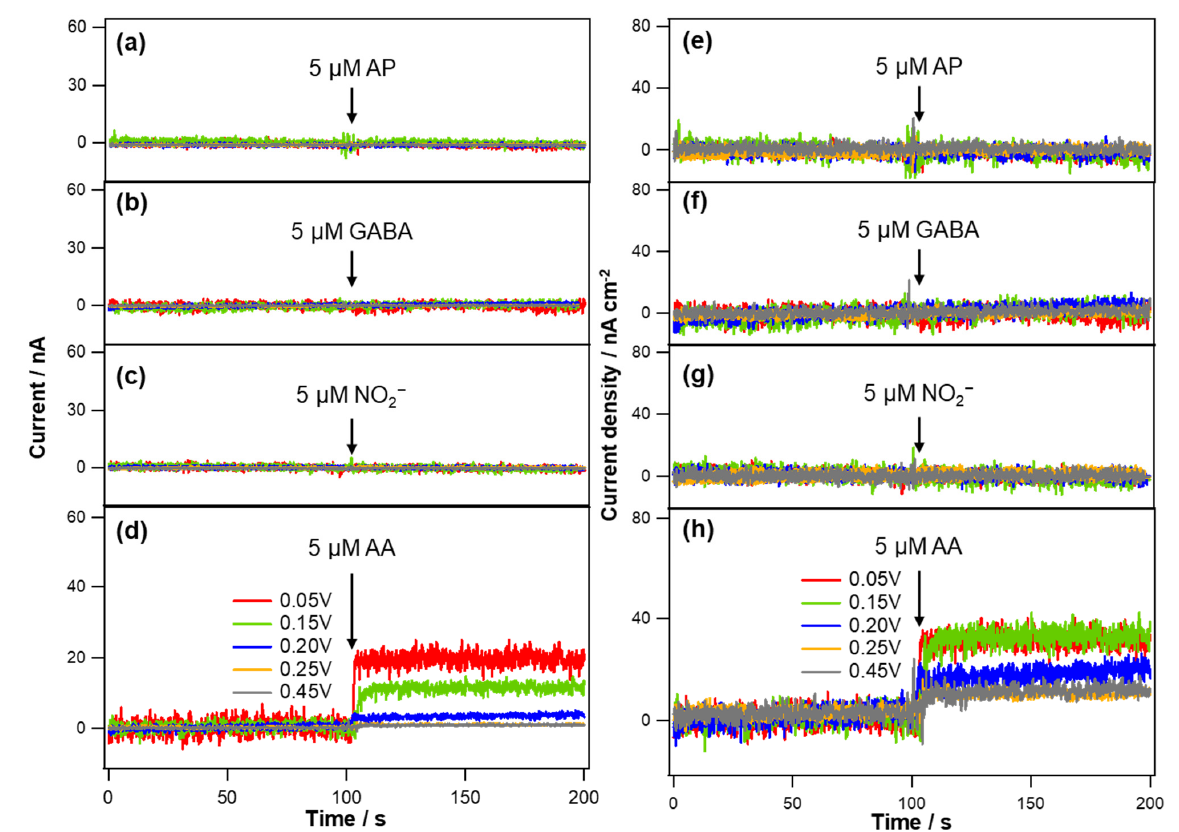
Figure 4. Typical current responses of the Au electrodes deposited with various deposition potentials to 5 µ M of ( a ) AP, ( b ) GABA, ( c ) NO 2 − and ( d ) AA in deareated PBS solution (pH 7.4) measured at an applied potential of − 0.05 V (vs. Ag/AgCl). ( e – h ) The current data in ( a – d ) were normalized to the corresponding electrode ESAs.